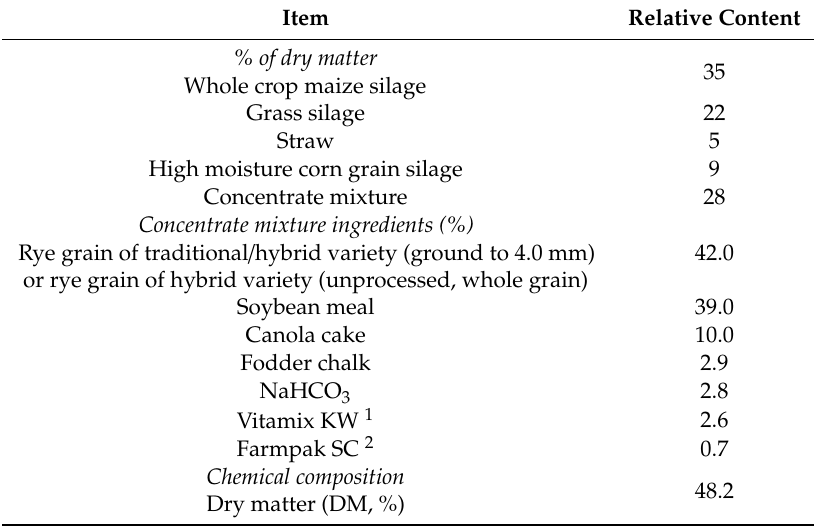
Table 1. Ingredients, chemical composition and nutritive value of total mixed ration.